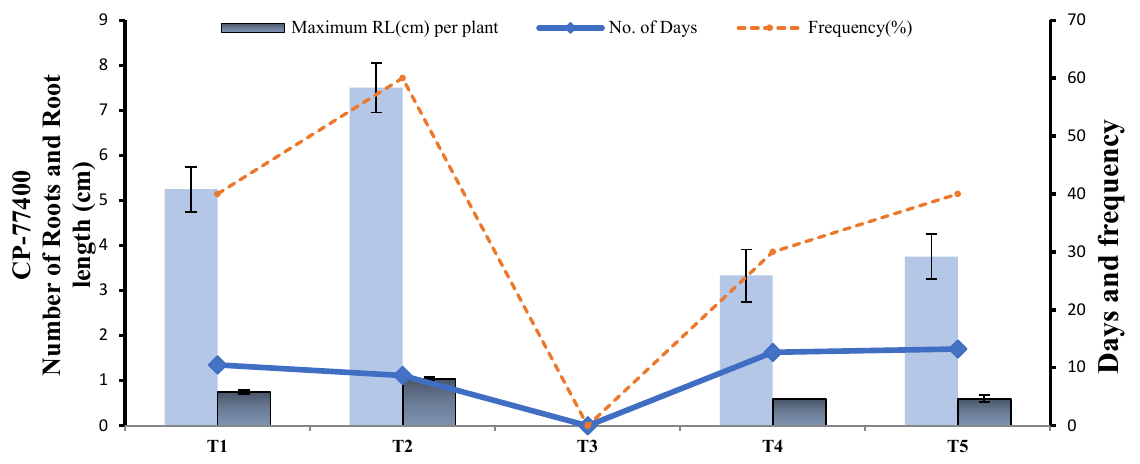
Figure 14. Effect of different media compositions on root induction in terms of root length (cm), number of roots, rooting frequency and number of days in CP-77400.